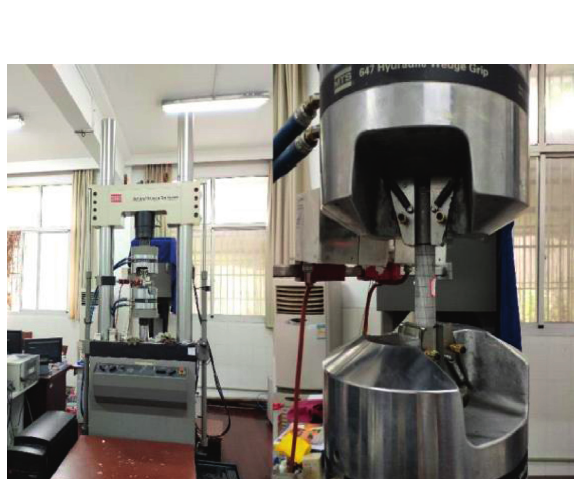
Figure 5: Torsion test performed on a standard specimen.